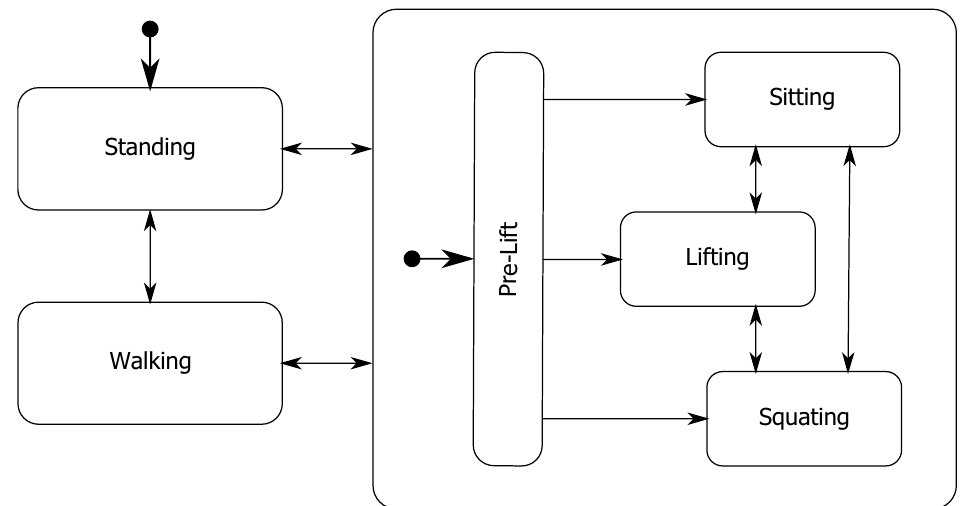
Figure 4. Structure of the state machine controller with all possible transitions between states. The states of pre-lift, squatting, lifting and sitting are grouped inside a superstate which allows transitions back to the walking or standing state. Arrows with circles denote initial